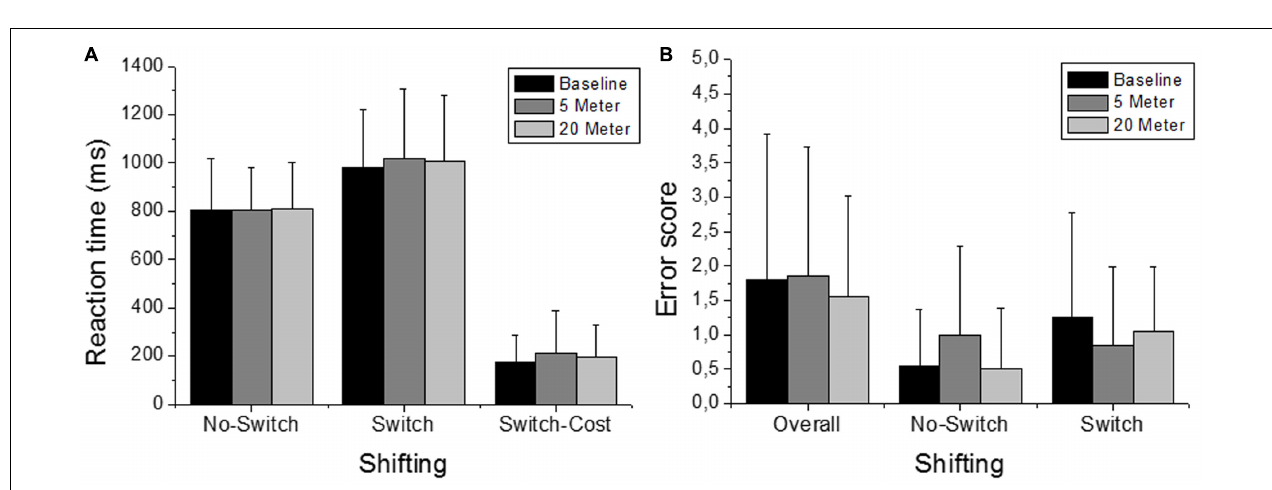
FIGURE 3 | Number/Letter task performance (i.e., shifting). Depicted are reaction times and the error scores. (A) Reaction times of the No-Switch trials and the Switch trials and the corresponding Switch-Costs. (B) “Overall” includes the errors that occurred in the complete test and separated errors for the different trials (No-Switch and Switch) are depicted separately as well. Values representing the arithmetic mean and error bars indicate the corresponding standard deviations.